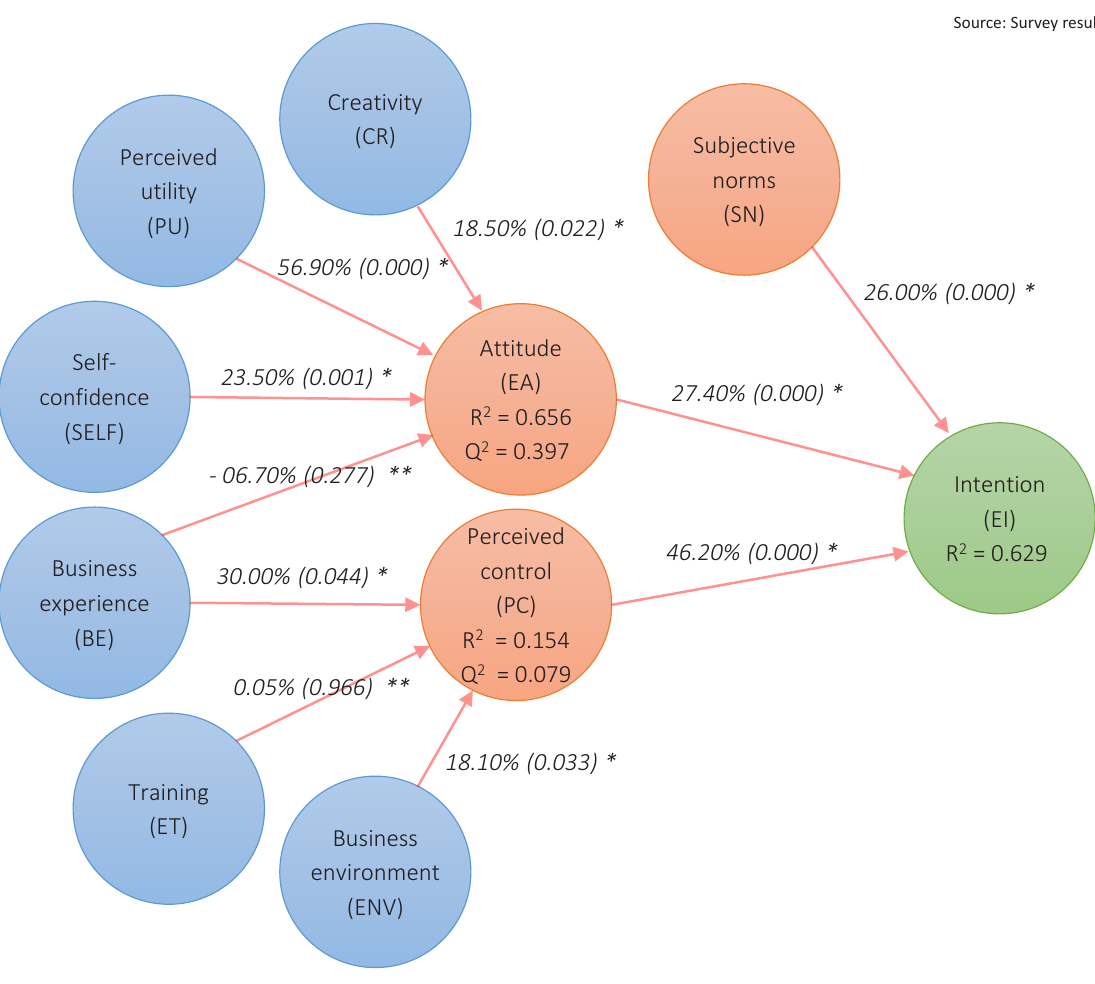
Figure 2. Structural model